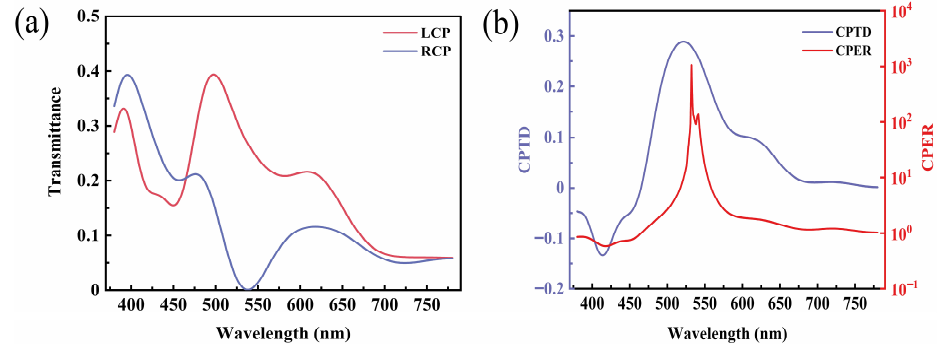
Figure 7. Simulation optical properties of the SCPMs. ( a ) Transmittance of the left-handed and right-handed circularly polarized light (T LCP and T RCP ) by the full visible band (380–780 nm) simulation. ( b ) Circular polarization transmittance difference (CPTD = T LCP − T RCP ) and circular polarization extinction ratio (CPER = T LCP /T RCP ) obtained by the T RCP and T LCP .